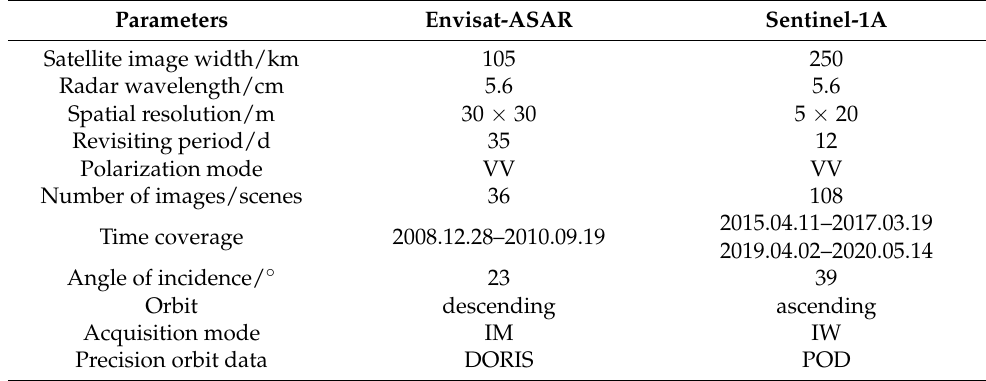
Table 1. SAR data parameters